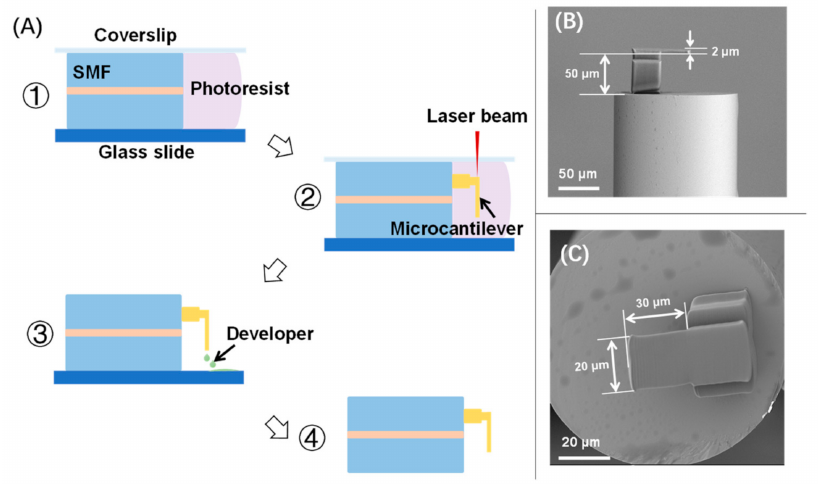
Figure 2. ( A ) Microfabrication process of a fiber-tip microcantilever by TPP technology based on fs laser; ( B , C ) are representative scanning electron microscopy (SEM) images of the fabricated